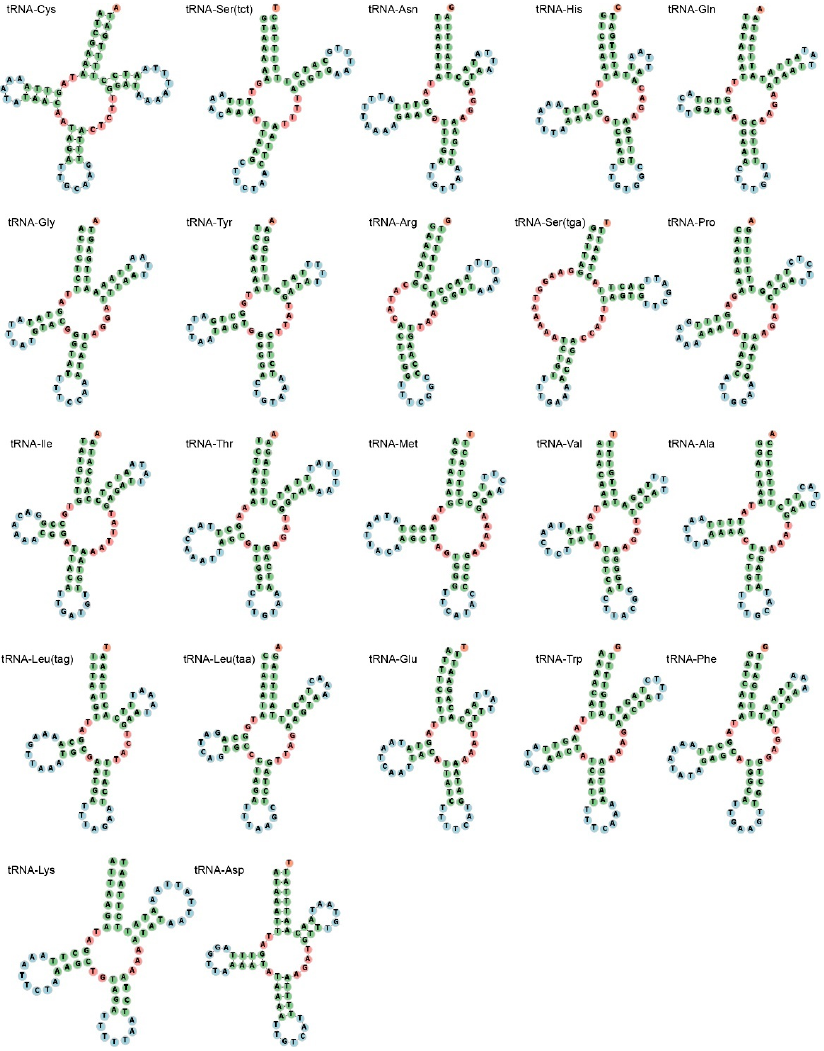
Figure 3. Cloverleaf structures of the 21 tRNA genes of P. vernedei mitochondrial genome.